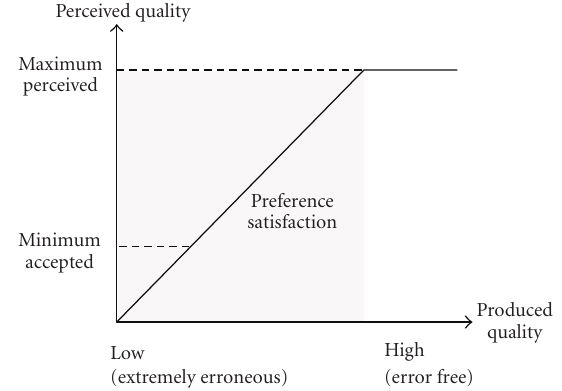
Figure 1: The levels of produced and perceived